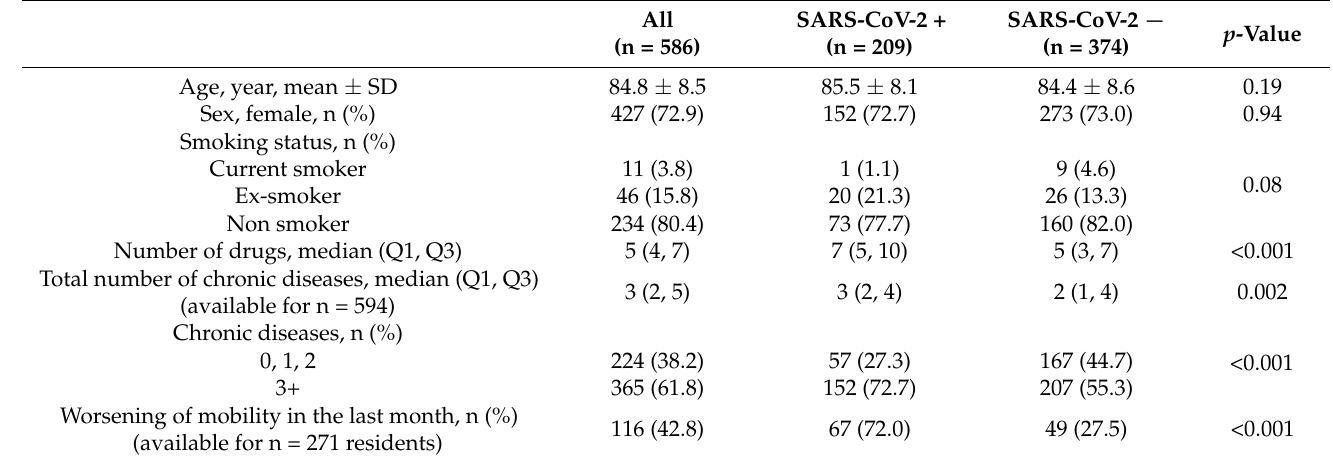
Table 1. Characteristics of older adults from the GeroCovid LTCFs study: overall population and by SARS-CoV-2 positive or negative swab